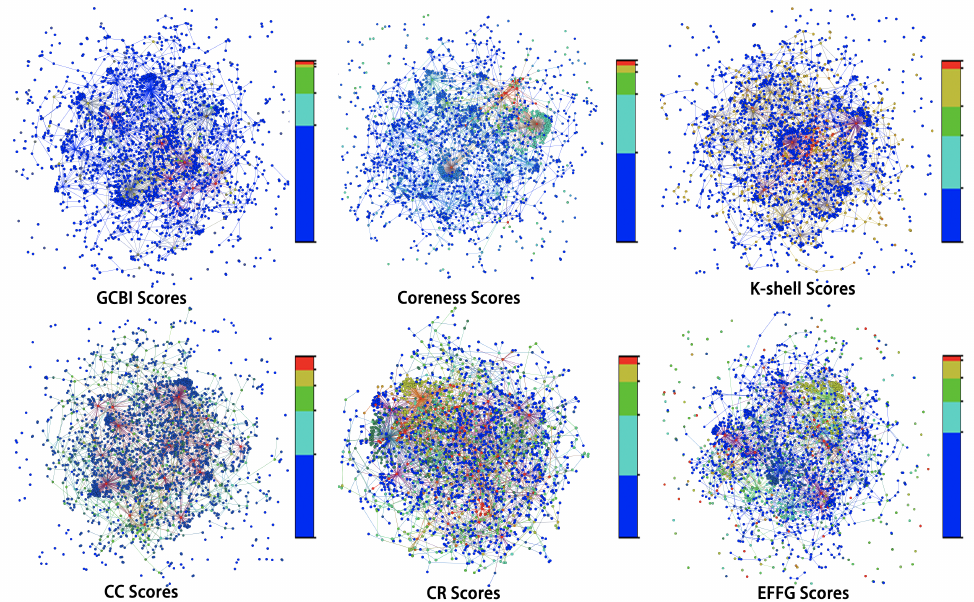
Figure 3. The heat map of different methods calculated influence scores in HBIN. Note that the proportion of different colors in the right color scale card indicates the proportion of nodes number in different influence score